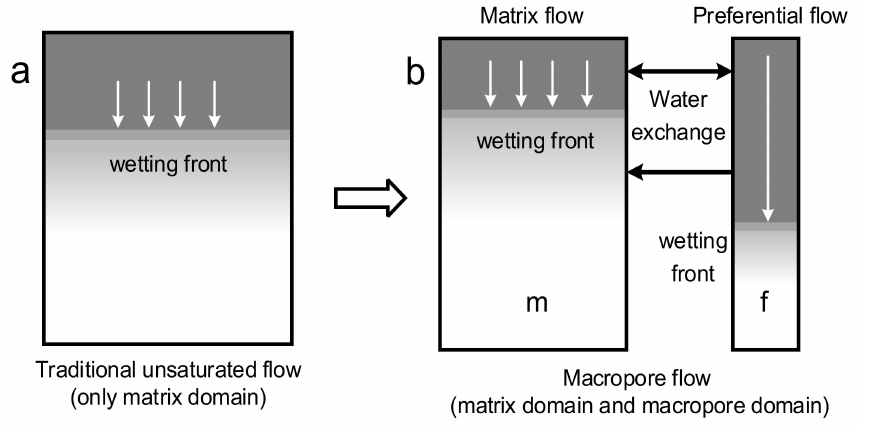
Figure 2. ( a ) Traditional unsaturated flow and ( b ) Macropore Flow ( m : Matrix Domain; f : Macropore